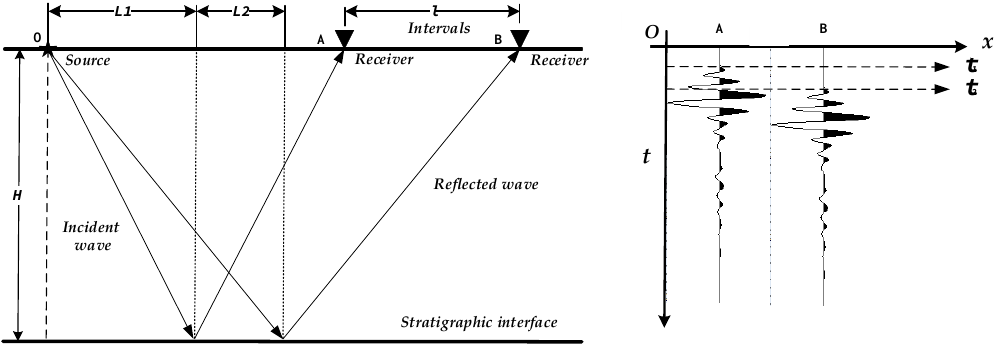
Figure 2. Double-receiver model of seismic reflection survey.